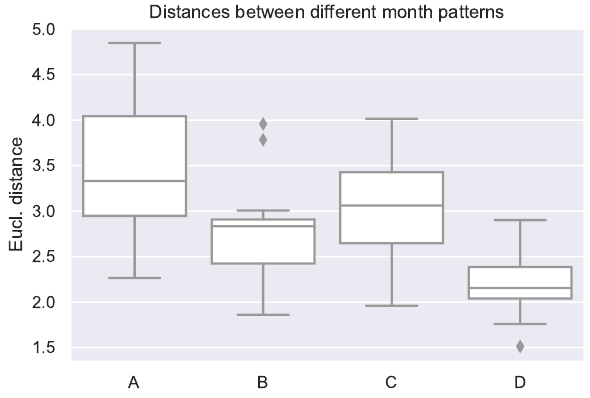
Figure 5. Euclidean distances between monthly usage patters for each of the monitored rooms (A–D).